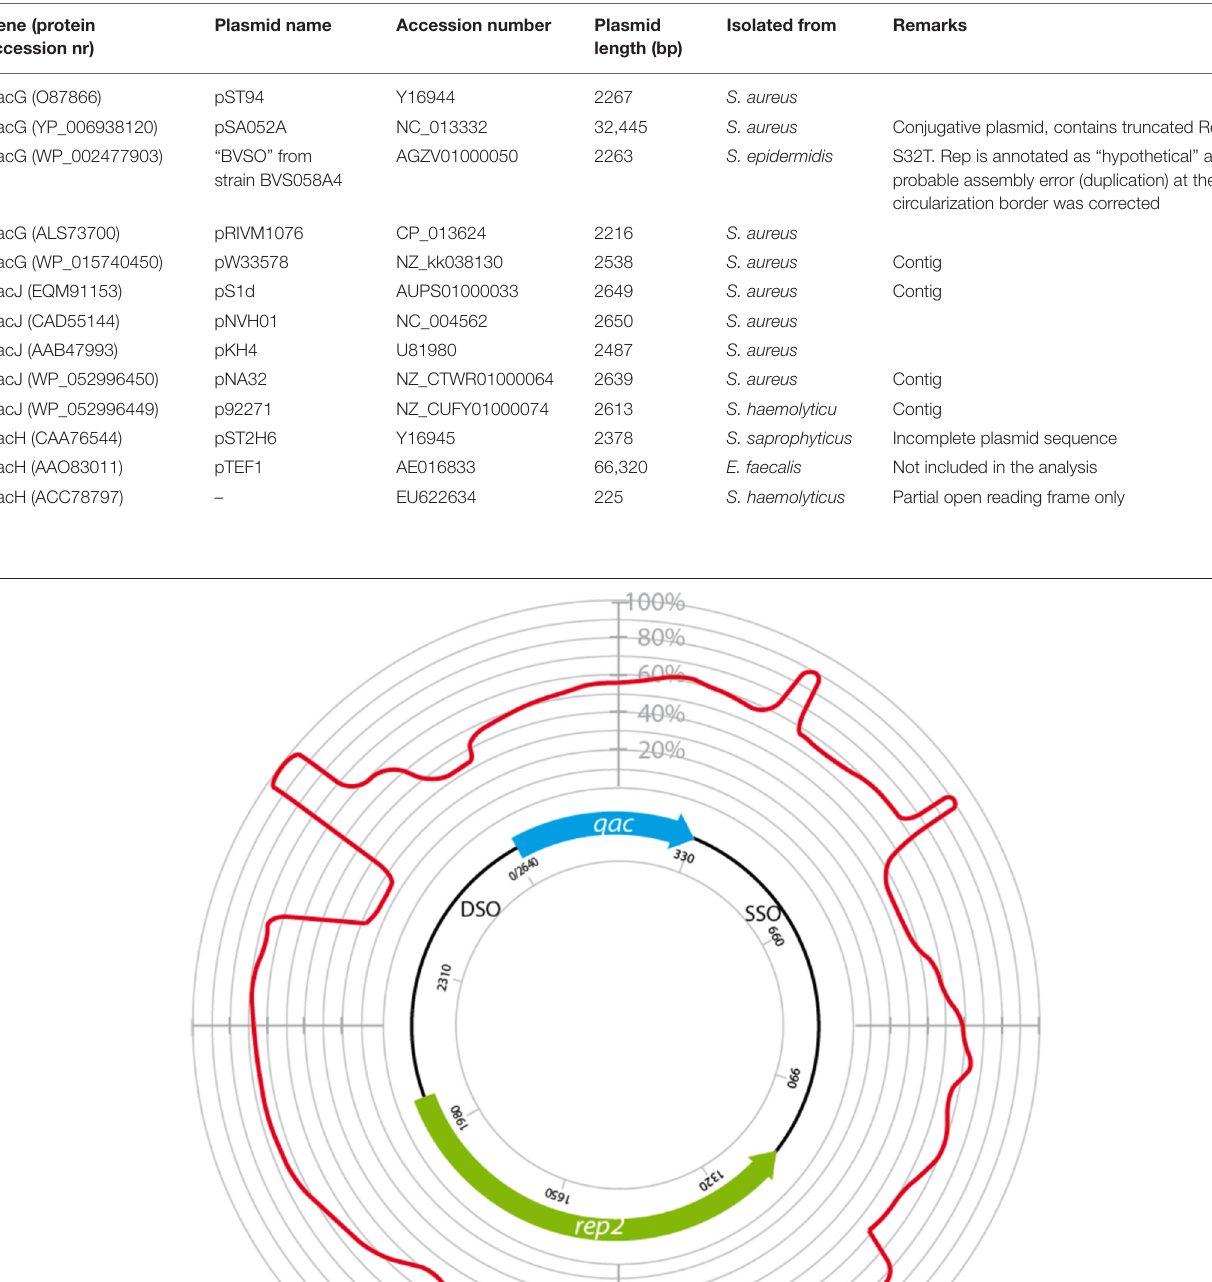
Frontiers in Microbiology |